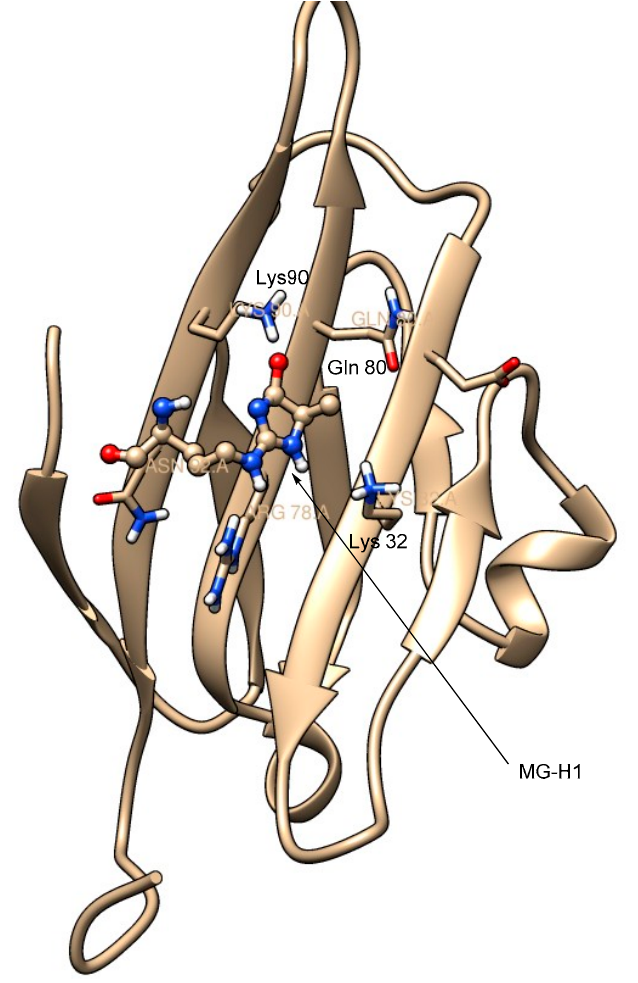
Figure 6. Solution NMR structure of the RAGE-MG-H1 complex (shown here is the extracellular V-domain of the RAGE bound to MG-H1); the imidazolone moiety of MG-H1 is surrounded by the positively charged amino acid residues, including Lys 90, Gln 80, and Lys 32; the structure was created using UCSF Chimera software; PDB ID: 2MOV (MG-H1 is shown as a ball-and-stick model; red = oxygen, blue = nitrogen).